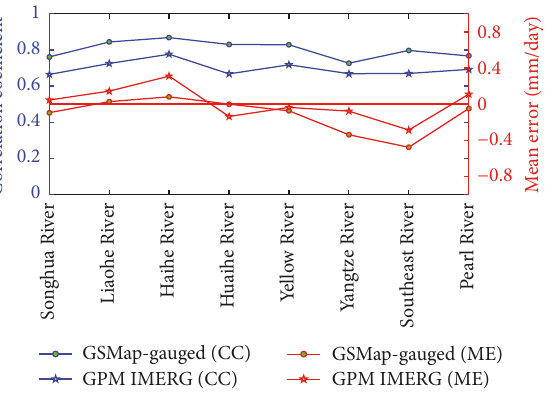
Figure 11: Spatially averaged CC and ME at the eight main basins over eastern China at the daily scale from April 2014 to March 2016.